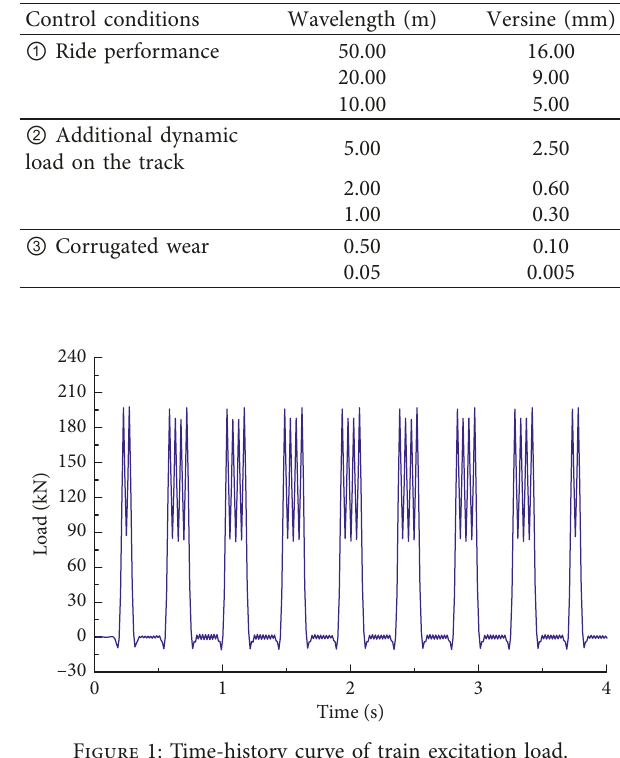
Table 1: Management value of track geometric irregularity in the UK.